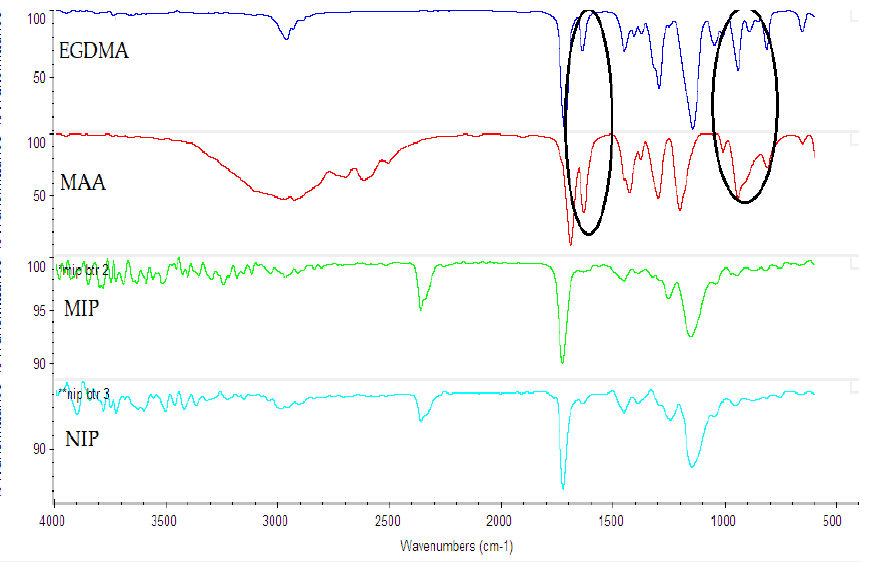
Figure 6. FTIR spectrum of MIP and NIP compared to EGDMA (cross-linker) and MAA (functional